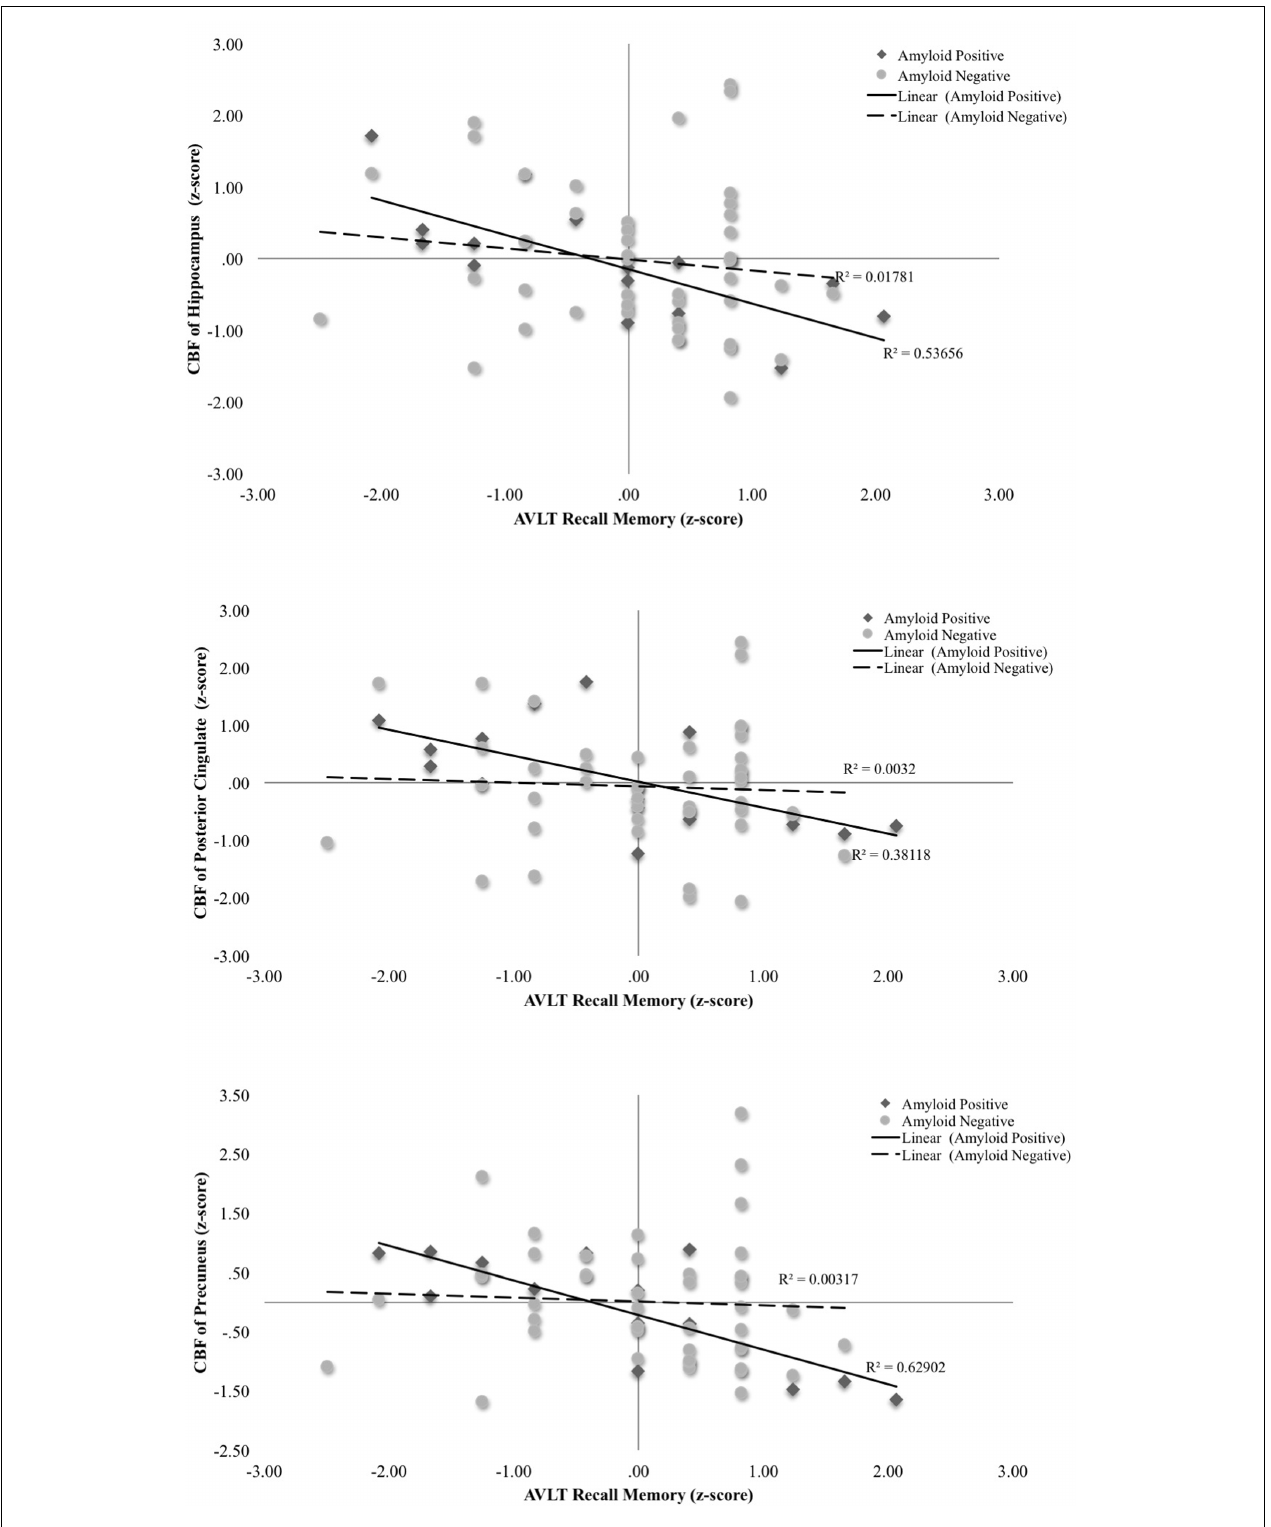
FIGURE 1 | Scatterplots of interaction of A β and cerebral blood flow on post-interference recall memory (Rey Auditory Verbal Learning Trial 5-Trial 6 raw z -score) for 3 a priori cortical regions of interest. A β positivity is based on threshold of based on the recommended threshold for cross-sectional florbetapir analyses of 1.11 using the whole cerebellum as the reference region. CBF is presented in standard deviation units. All interactions were statistically significant ( p < 0.05).